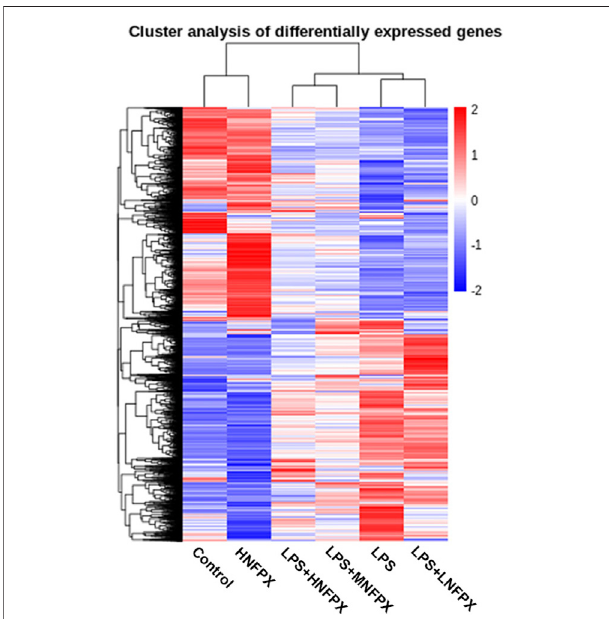
FIGURE 10 | Hierarchical clustering analysis of genes that were differentially expressed in lung tissue samples using heatmap; each group contains four to fi ve individuals. Blue-white indicates lower expression, and red indicates high expression.